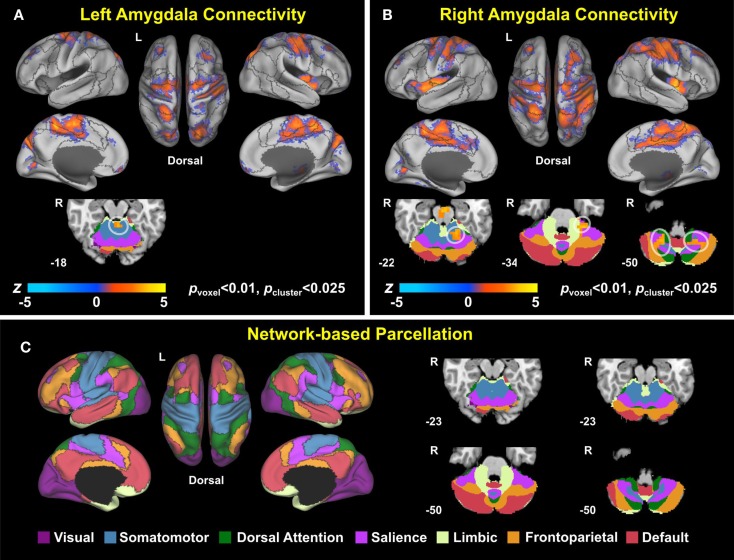
Group comparison maps overlaid on network-based parcelation (106, 107). (A) Left amygdala connectivity, (B) right amygdala connectivity, (C) network-based parcellation. Note that we renamed the ventral attention network (VAN) in Buckner et al. (106) and Yeo et al. (107) as the salience network (SN) since (1) the VAN in Buckner et al. (106) and Yeo et al. (107) is an aggregate of multiple networks, including the SN and (2) most of the corresponding regions in the conjunction map fell onto the SN (35).